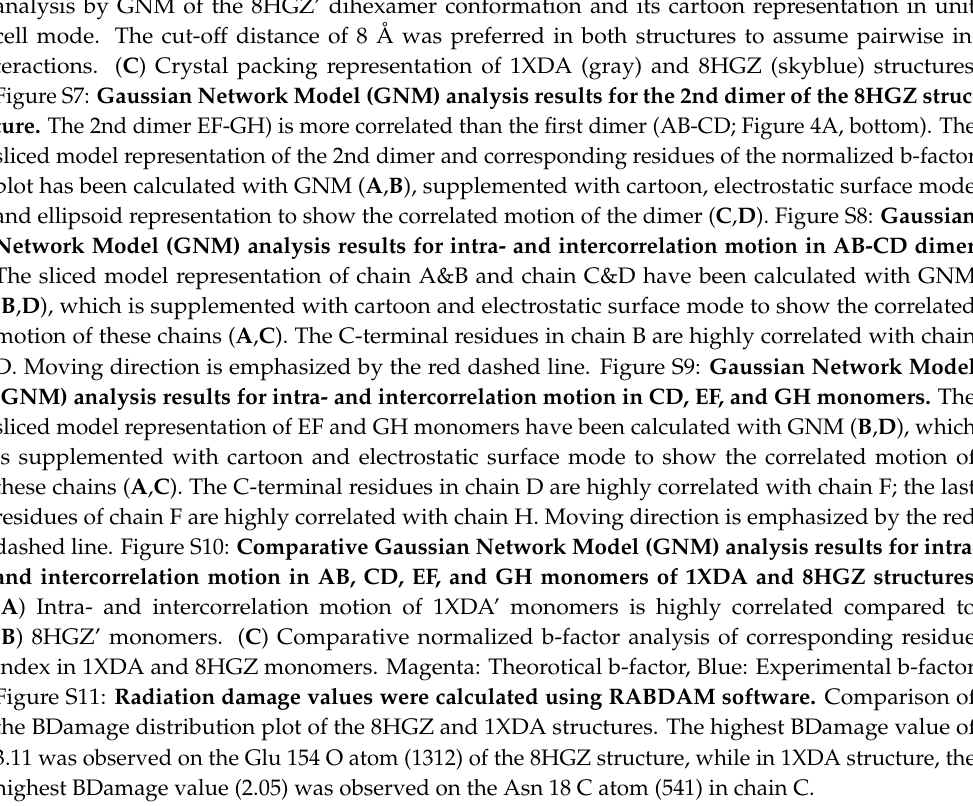
1XDA’ dihexamer conformation and its cartoon representation in unit cell mode. ( B ) Cross-correlation analysis by GNM of the 8HGZ’ dihexamer conformation and its cartoon representation in unit cell mode. The cut-off distance of 8 Å was preferred in both structures to assume pairwise in- teractions. ( C ) Crystal packing representation of 1XDA (gray) and 8HGZ (skyblue) structures. Figure S7: Gaussian Network Model (GNM) analysis results for the 2nd dimer of the 8HGZ struc- ture. The 2nd dimer EF-GH) is more correlated than the first dimer (AB-CD; Figure 4A, bottom). The sliced model representation of the 2nd dimer and corresponding residues of the normalized b-factor plot has been calculated with GNM ( A , B ), supplemented with cartoon, electrostatic surface mode and ellipsoid representation to show the correlated motion of the dimer ( C , D ). Figure S8: Gaussian Network Model (GNM) analysis results for intra- and intercorrelation motion in AB-CD dimer. The sliced model representation of chain A&B and chain C&D have been calculated with GNM ( B , D ), which is supplemented with cartoon and electrostatic surface mode to show the correlated motion of these chains ( A , C ). The C-terminal residues in chain B are highly correlated with chain D. Moving direction is emphasized by the red dashed line. Figure S9: Gaussian Network Model (GNM) analysis results for intra- and intercorrelation motion in CD, EF, and GH monomers. The sliced model representation of EF and GH monomers have been calculated with GNM ( B , D ), which is supplemented with cartoon and electrostatic surface mode to show the correlated motion of these chains ( A , C ). The C-terminal residues in chain D are highly correlated with chain F; the last residues of chain F are highly correlated with chain H. Moving direction is emphasized by the red dashed line. Figure S10: Comparative Gaussian Network Model (GNM) analysis results for intra- and intercorrelation motion in AB, CD, EF, and GH monomers of 1XDA and 8HGZ structures. ( A ) Intra- and intercorrelation motion of 1XDA’ monomers is highly correlated compared to ( B ) 8HGZ’ monomers. ( C ) Comparative normalized b-factor analysis of corresponding residue index in 1XDA and 8HGZ monomers. Magenta: Theorotical b-factor, Blue: Experimental b-factor. Figure S11: Radiation damage values were calculated using RABDAM software. Comparison of the BDamage distribution plot of the 8HGZ and 1XDA structures. The highest BDamage value of 3.11 was observed on the Glu 154 O atom (1312) of the 8HGZ structure, while in 1XDA structure, the highest BDamage value (2.05) was observed on the Asn 18 C atom (541) in chain